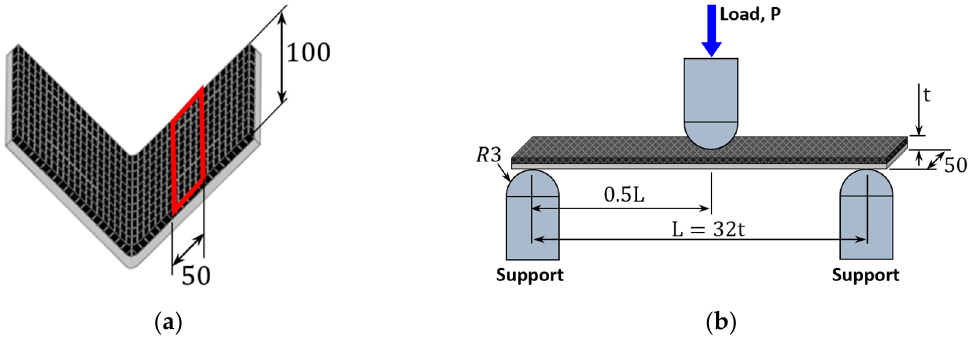
Figure 2. Schematic diagram of three-point bending test for hybrid composites: ( a ) specimen; ( b ) test method.